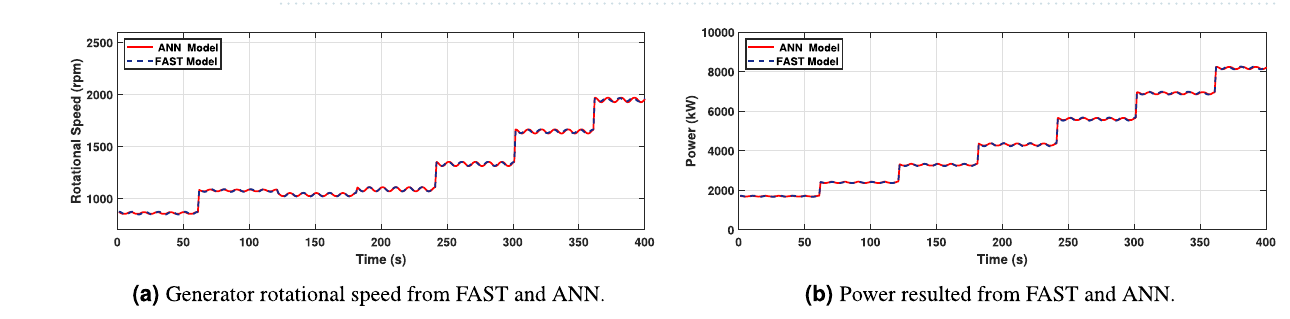
Figure 15. Platform‘ Roll angle and side-to-side displacement.